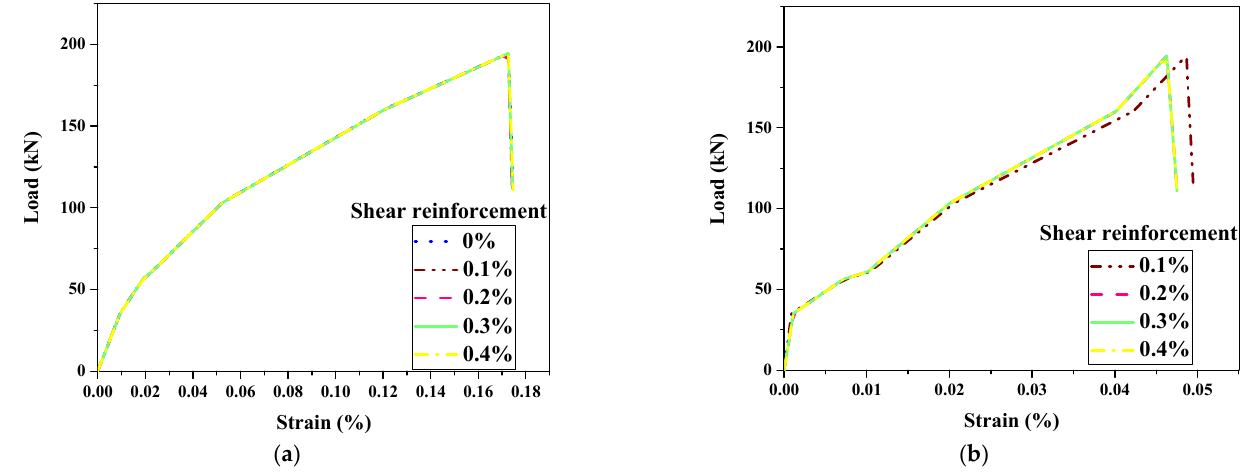
Figure 13. Typical load–strain response: ( a ) longitudinal main bar at mid-span; ( b ) stirrups. Table 7. Contribution of shear load from ECC and stirrups. Beam Total Shear Capacity